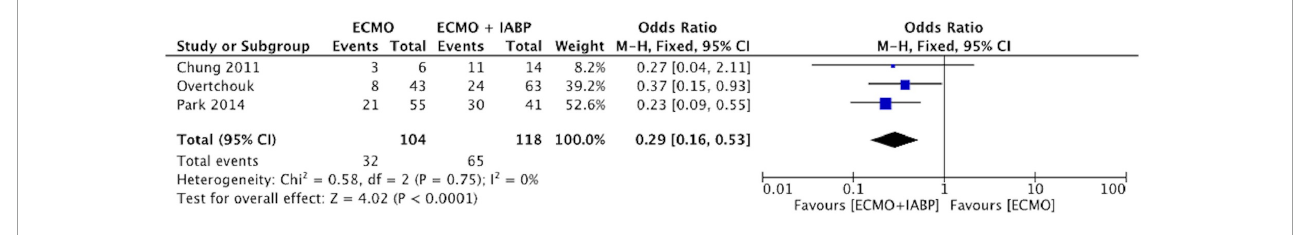
FIGURE4 Forest plot on weaning success of ECMO + IABP vs. ECMO. Individual studies and pooled analysis showing a significant increased successful ECMO weaning for patients in cardiogenic shock due to acute myocardial infarction treated with ECMO + IABP compared to patients with ECMO only ( p < 0.001). CI, confidence interval; OR, odds ratio.